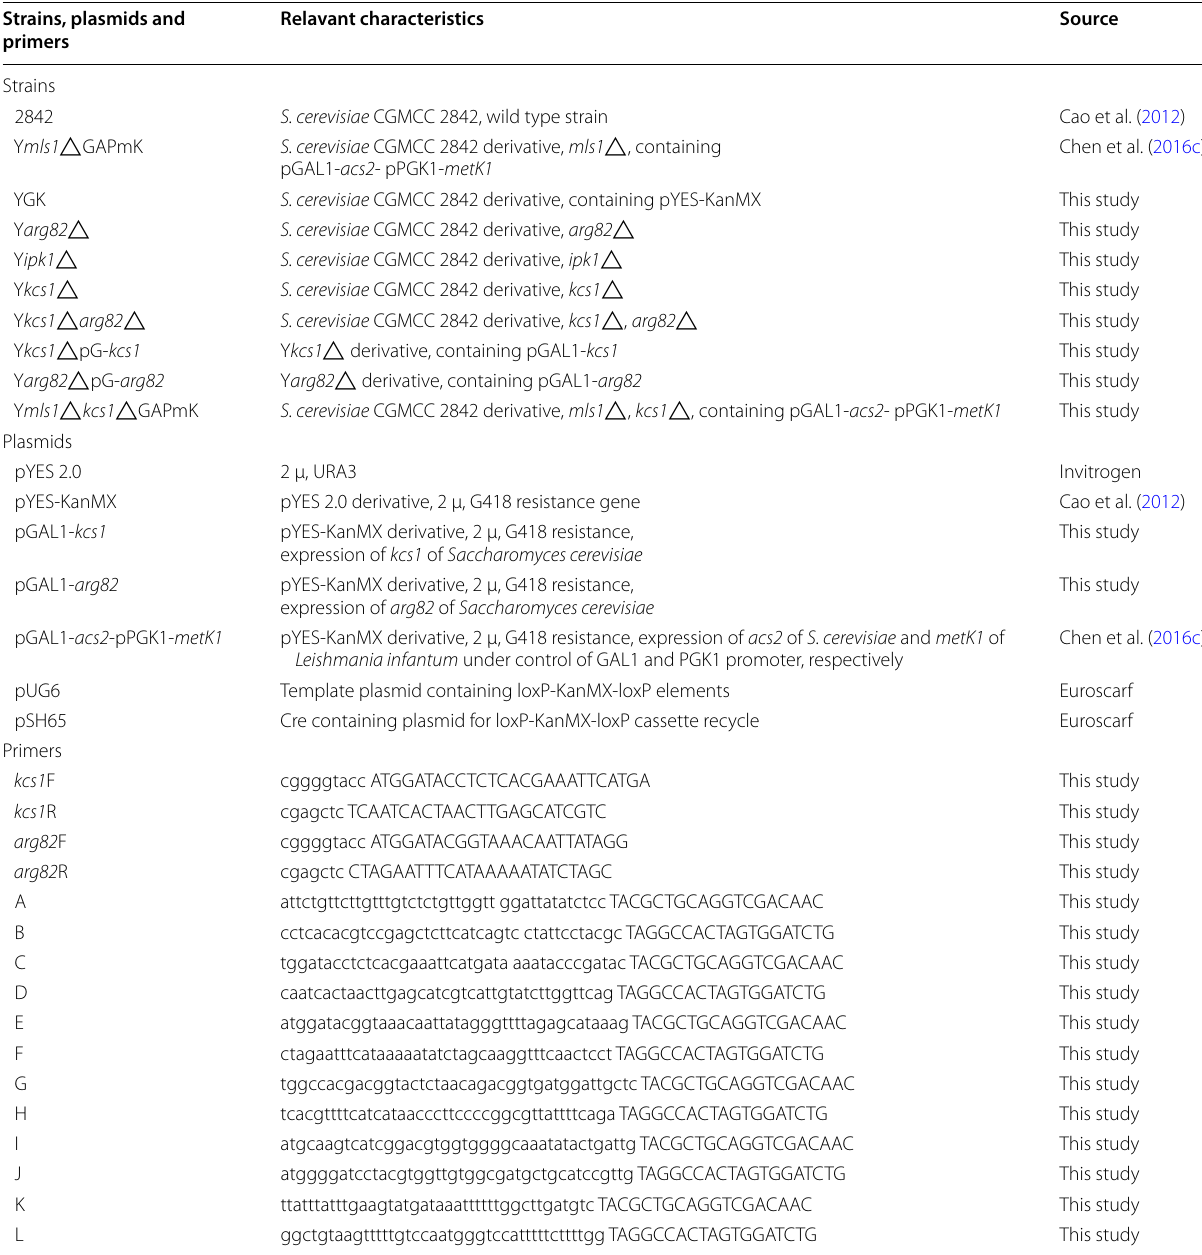
Table 1 Strains, plasmids and primers Strains, plasmids and